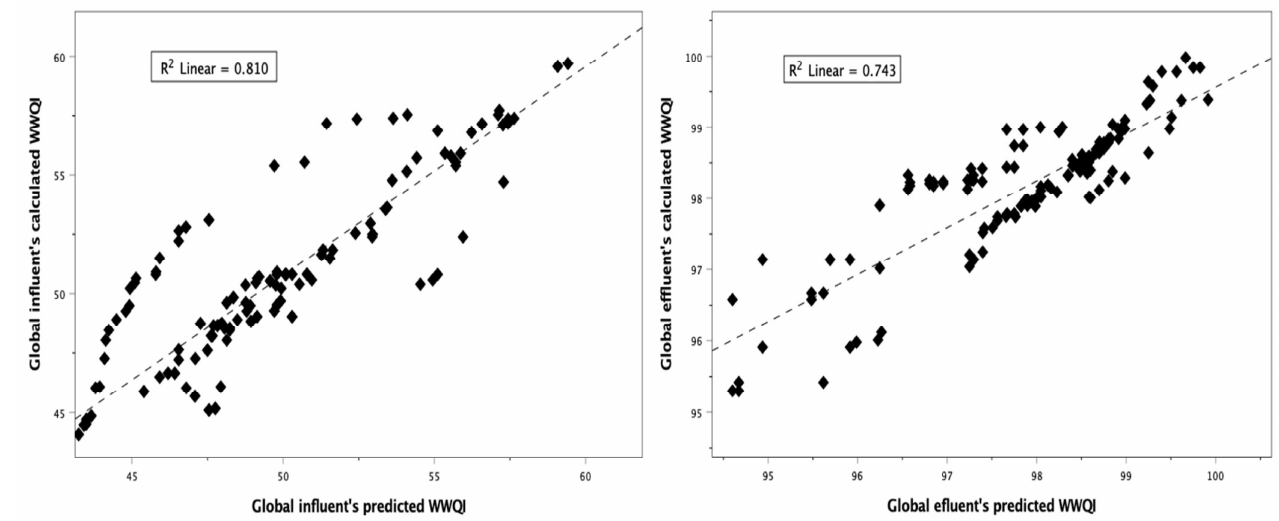
Figure 5. Scatter plots of calculated and predicted global WWQI values.